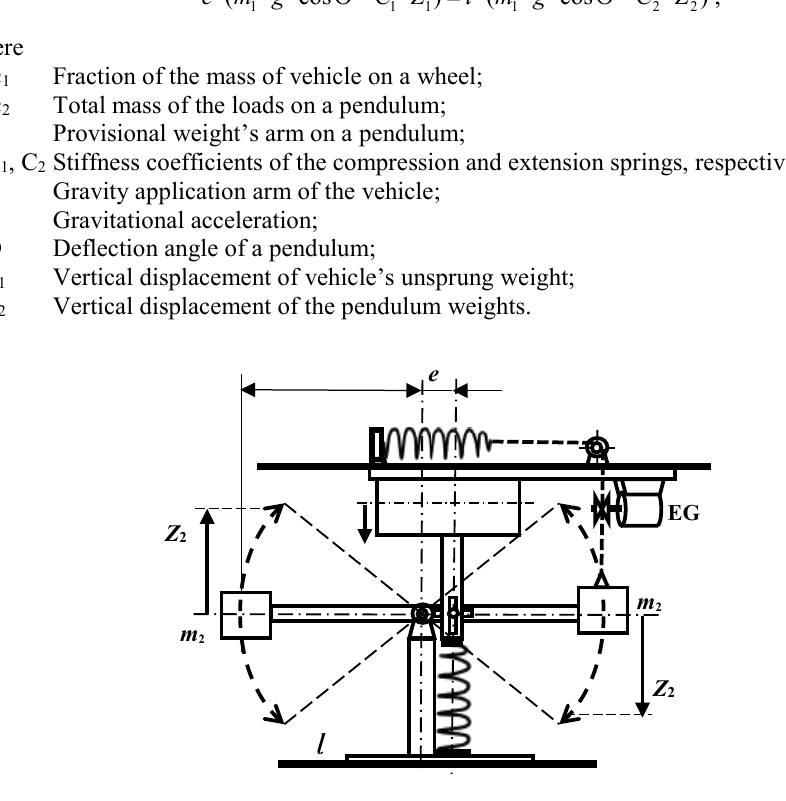
Fig. 2. The design kinematic scheme of a pendulum-type suspension of vehicle.